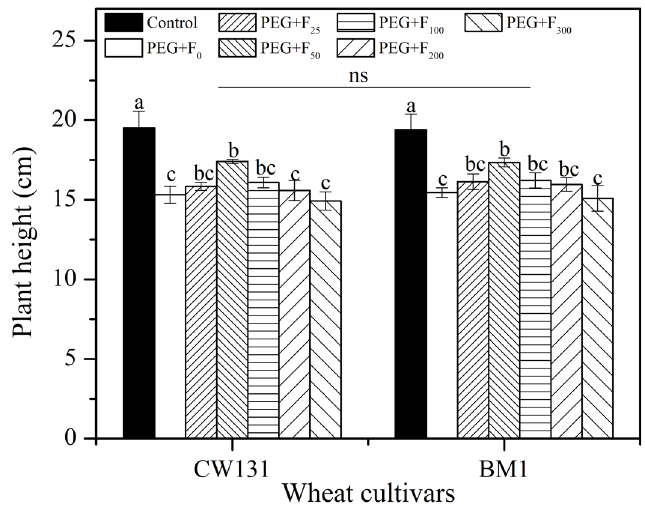
Figure 2. Effect of different fullerol additions (concentrations range from 0 to 300 mg L − 1 ) on the plant heights of two wheat cultivars (CW131 and BM1) under PEG (20% polyethylene glycol) treatment. Mean values ± SE are shown ( n = 3). Bars with different letters for the same cultivar imply a significant difference at p < 0.05. For ANOVA results, ns, not significant.